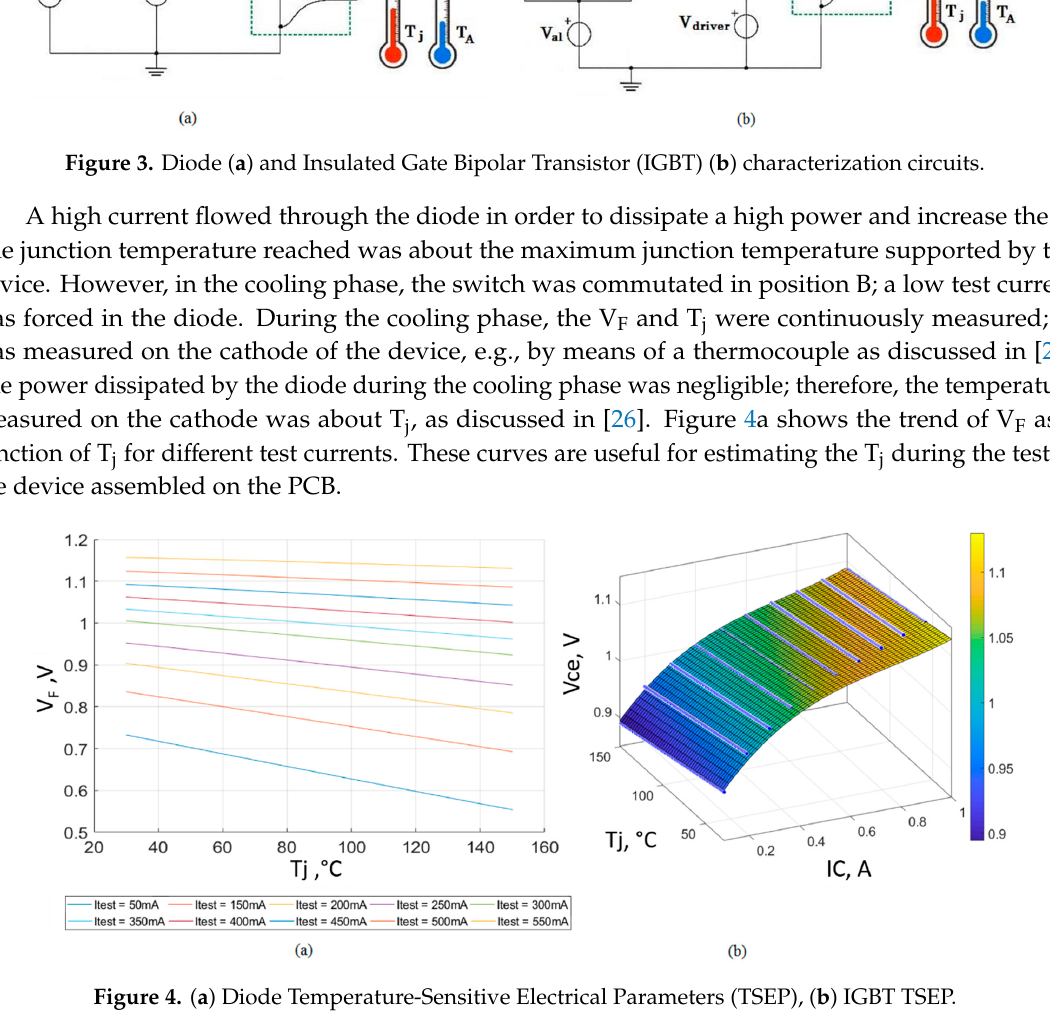
Figure 3. Diode ( a ) and Insulated Gate Bipolar Transistor (IGBT) ( b ) characterization circuits.